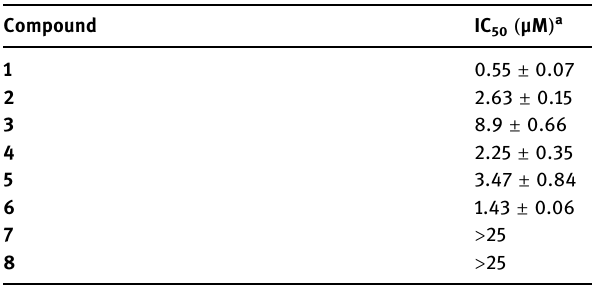
Table 2: IC 50 values of compounds 1 – 8 for L929 cell line after 24